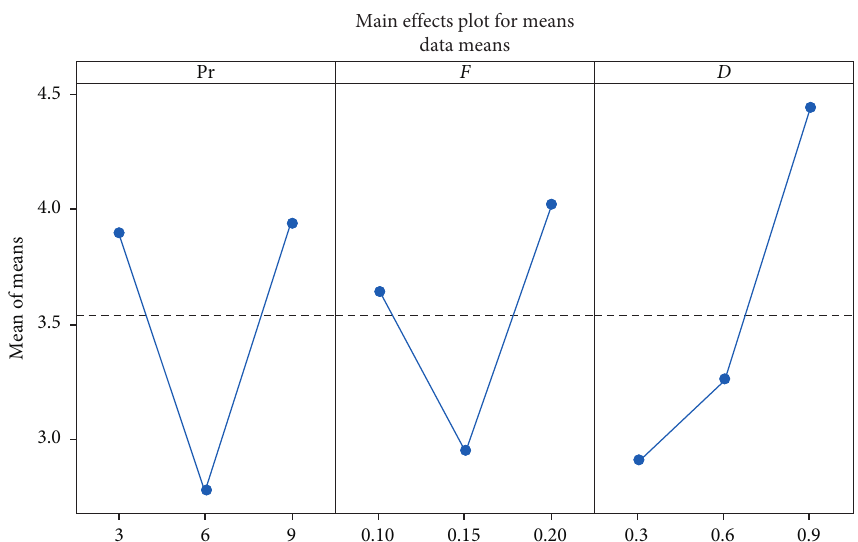
Figure 6: Mean-based important effect diagram for the roughness on the machined surface; in the X –axis, Pr denotes pressure (bar), F denotes feed (mm/rev), and D denotes depth of cut